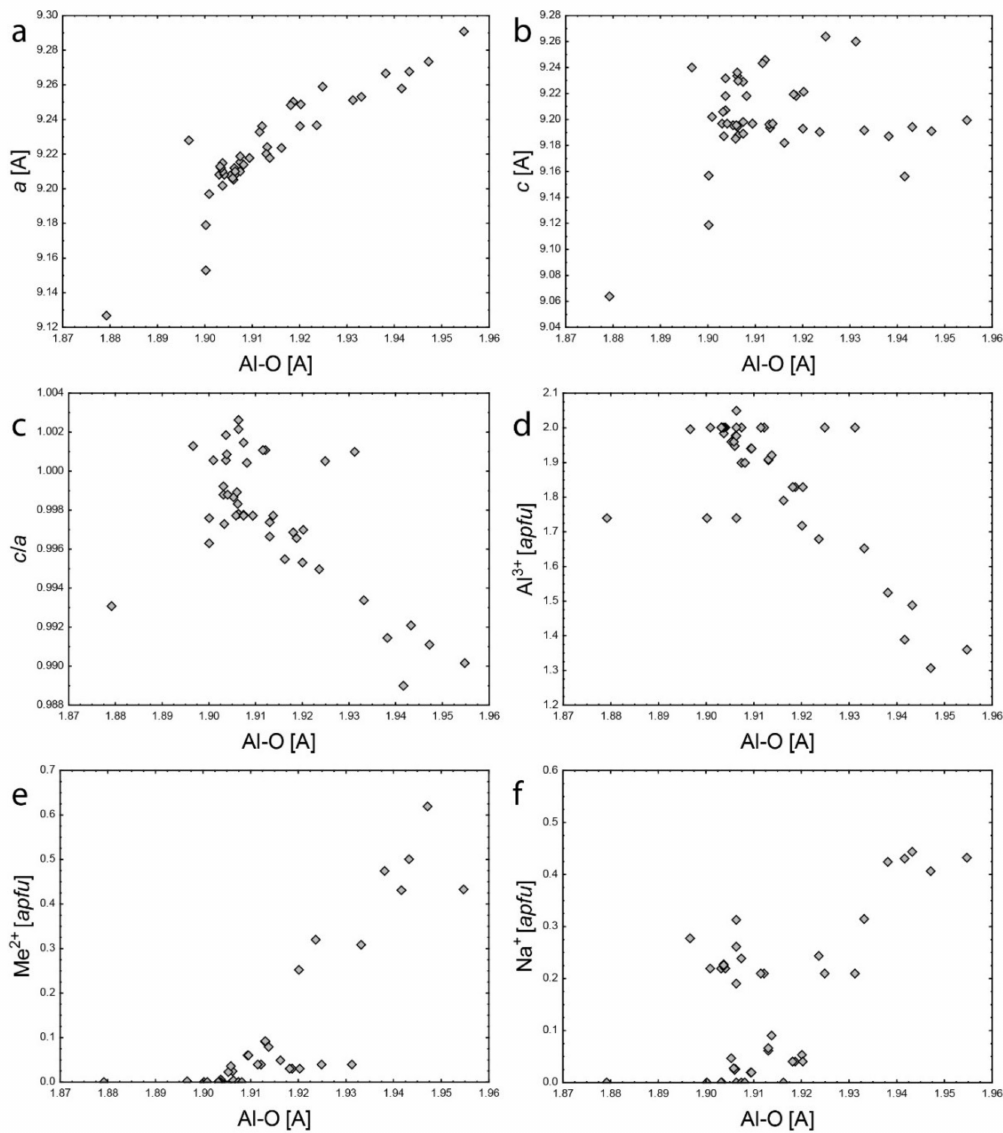
Figure 6. Comparison of Al 3 + –O bond length to: ( a ) a ; ( b ) c ; ( c ) c / a ; ( d ) Al 3 + ; ( e ) Me 2 + (Me = Fe 2 + + Mg 2 + + Mn 2 + ); ( f ) Na +